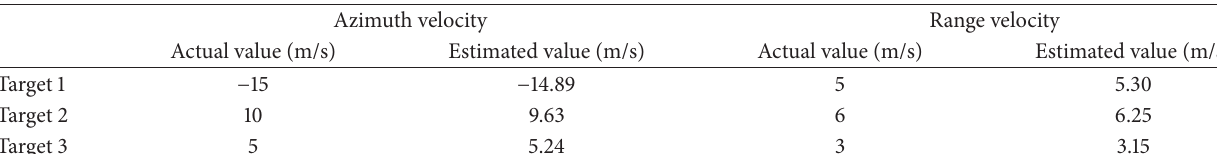
Table 3: Motion estimation results.